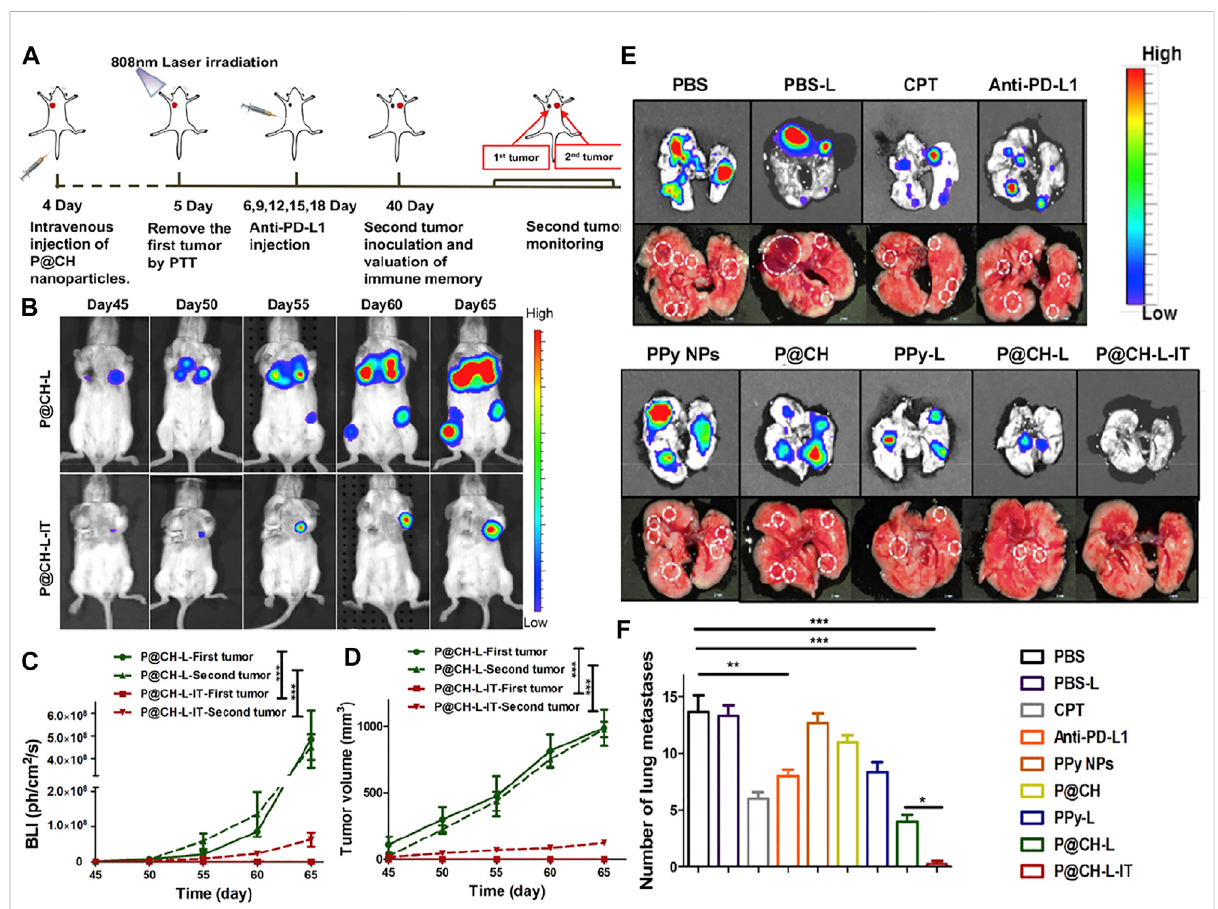
FIGURE 6 (A) Schemeshowingtherechallengeexperimentaldesigntoevaluate theimmune-memoryeffect. (B) ThedynamicBLIimagesofrechallenged mice from the P@CH-L and P@CH-L-IT groups ( n = 5) for 65 continuous days. (C) Quanti fi cation of the BLI signal intensity of rechallenged tumors. (D) Tumorvolume measurement ofsecondrechallenged tumorsand fi rsttumorsintwogroups.Chemo-photothermaltherapyincombinationwith immune checkpoint blockade therapy prevented lung metastases. (E) Representative BLI images and white-light pictures showing the lung metastases. (F) The number of lung metastasis nodules of different groups ( n = 3). Reproduced with permission from ref (Chen et al., 2019). CC